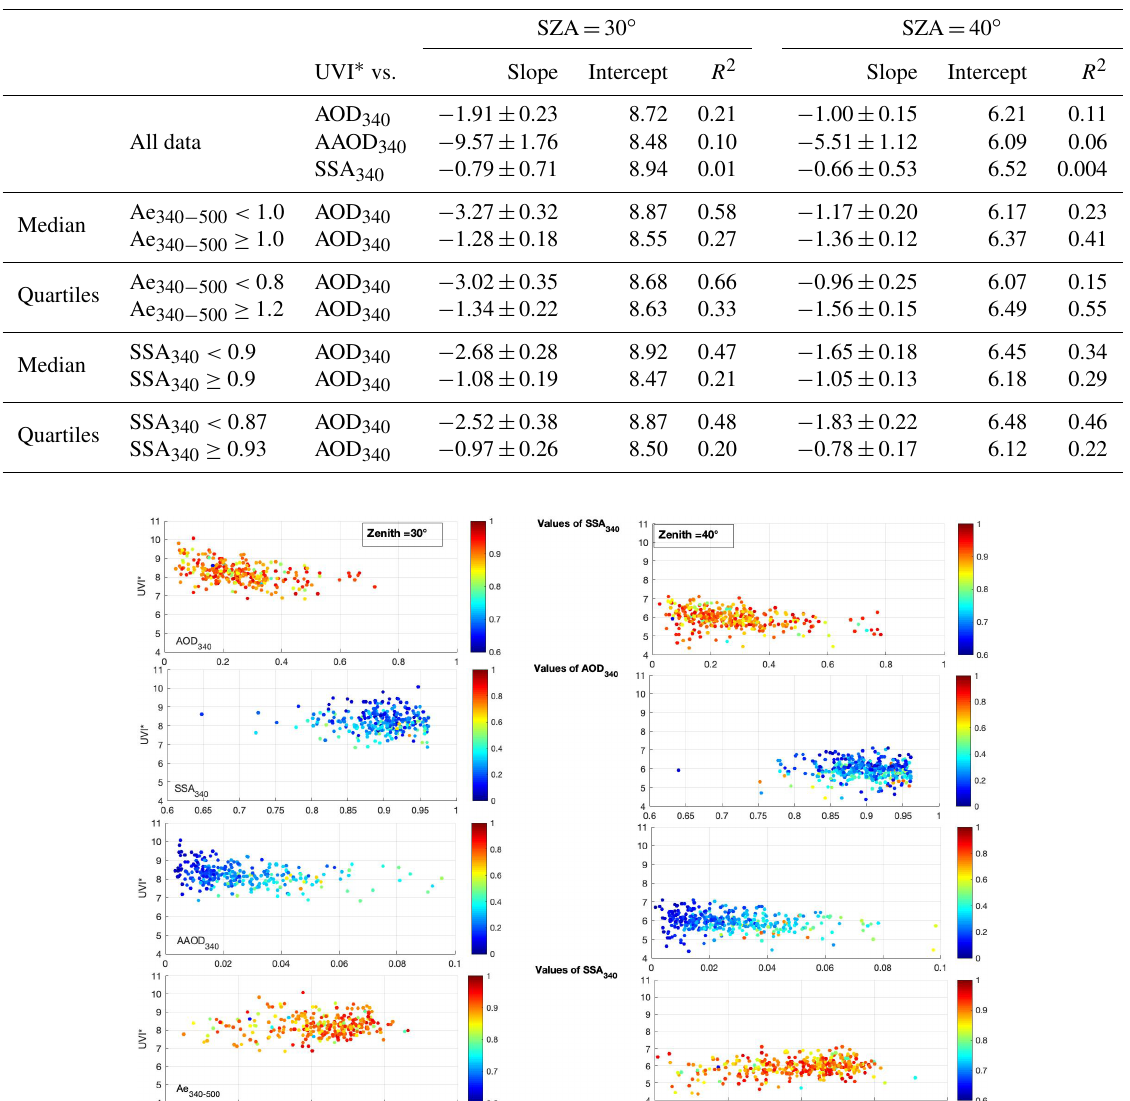
Table 1. Slope, intercept, and determination coefficient values for the linear fit of UVI ∗ vs. AOD 340 , AAOD 340 , and SSA 34 for different cases and the two zenith angles.